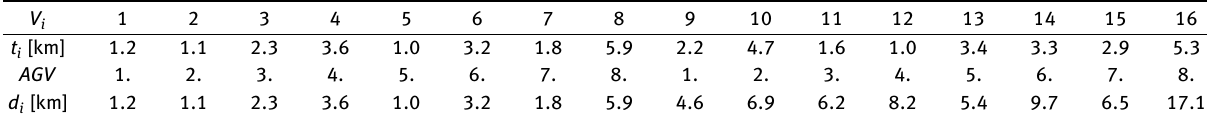
Table 5: Calculation of the d i parameter based on distances between V 0 and V i for eight AGV V i